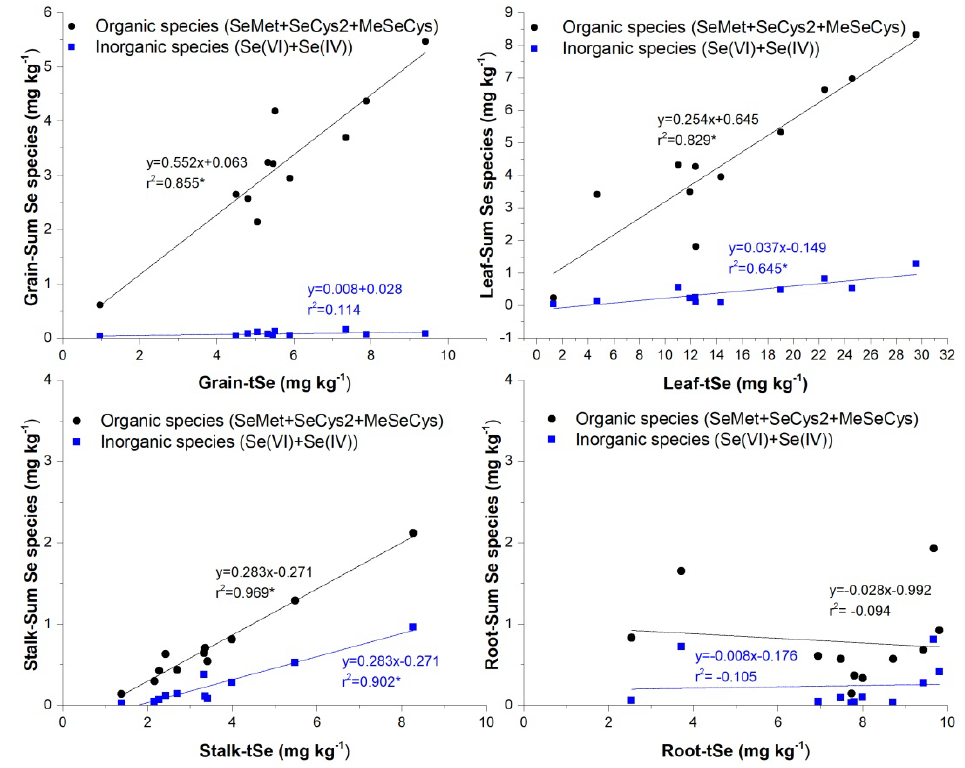
Figure 5. Regressions between organic and inorganic Se species when compared to tSe concentrations (* p < 0.05, correlation coefficient).